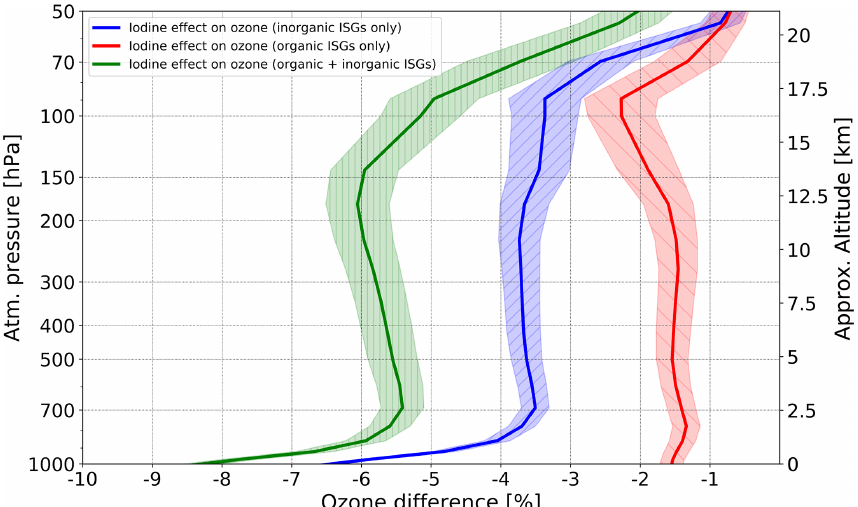
Figure 9. Modeled vertical profiles of O 3 reduction by iodine from organic, inorganic, and total surface emissions averaged over the tropics (20 ◦ N–20 ◦ S), for the 2000–2009 period and 10 ensemble members. Red curve: difference in O 3 relative to the control run (0 × iodine), if only organic iodine source gases are considered; blue curve: a percentage difference in O 3 relative to the control run (0 × iodine), if inorganic iodine source gases are only considered; green curve: a percentage difference in O 3 relative to the control run (0 × iodine), if both organic and inorganic iodine source gases are considered. Shadings represent a standard deviation of ensemble members. The results have a confidence level more than or equal to